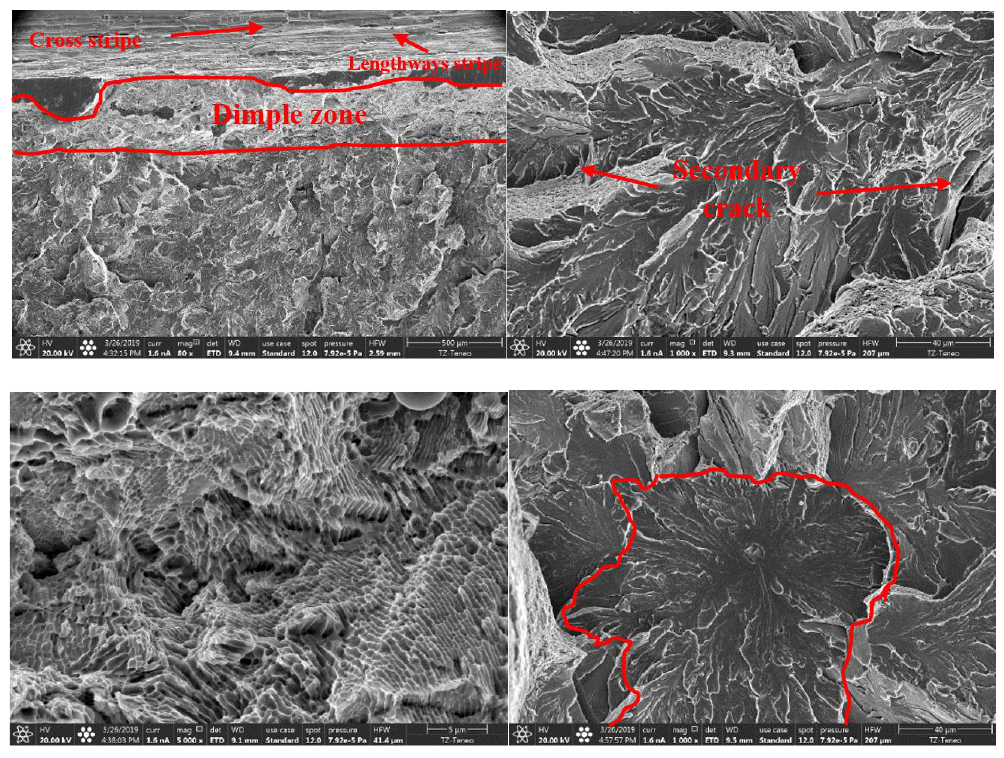
Figure 7. Fracture morphology of sample 1#.